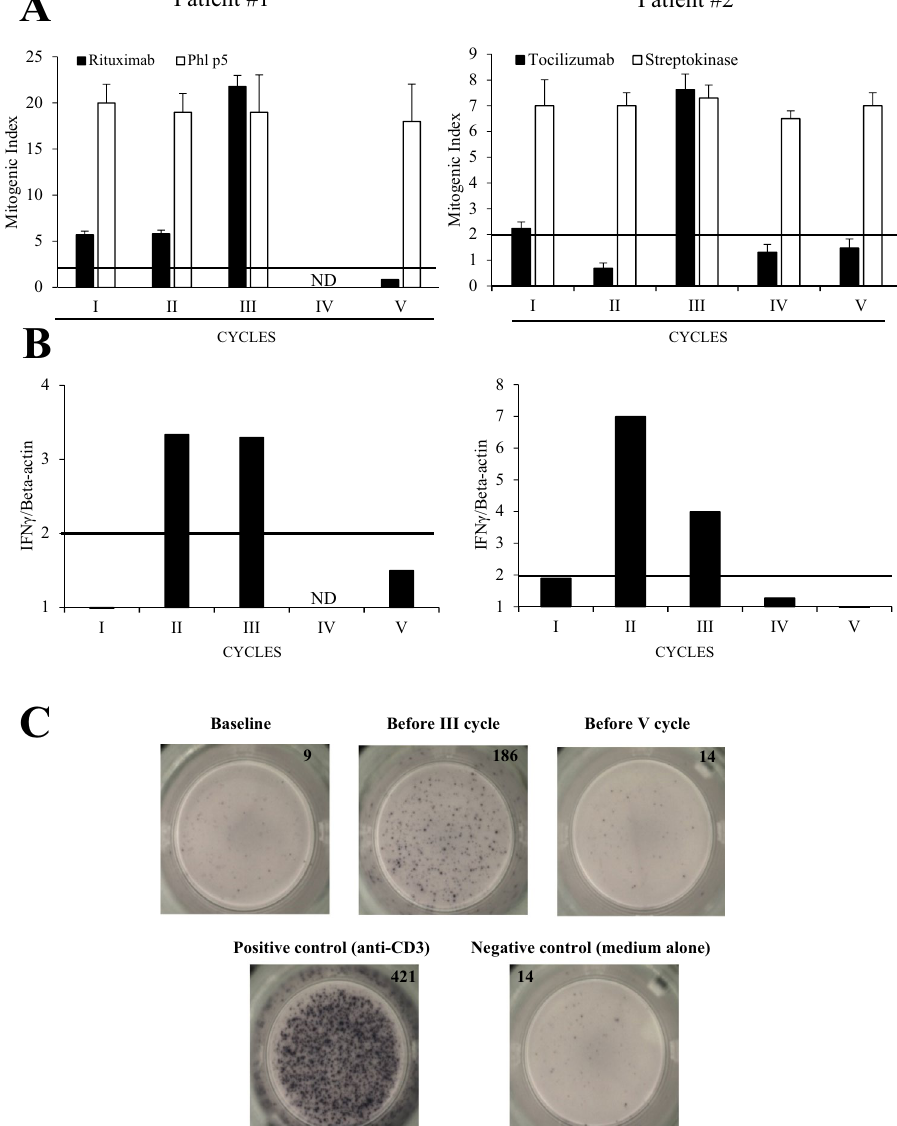
Figure 3. ( A ) Desensitization effects on PBMC proliferation to drug and Phl p5 allergen or streptokinase, evaluated by 3 H uptake. ( B ) IFN-γ mRNA expression in drug-stimulated PBMC at different desensitization cycles. ( C ) IFN-γ-producing T cells upon tocilizumab-specific stimulation on ELISPOT assay. IFN interferon, PBMC peripheral blood mononuclear cells, Phl p5 Phleum pratensis